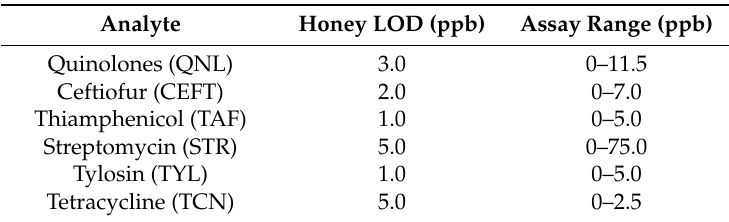
Table 1. Detection limits and assay range of the Evidence Investigator™ AM II analytes. Antibiotics with a value lower than the detection limits of the instrument cannot be detected and, consequently, they are indicated as N.D. (not detected).